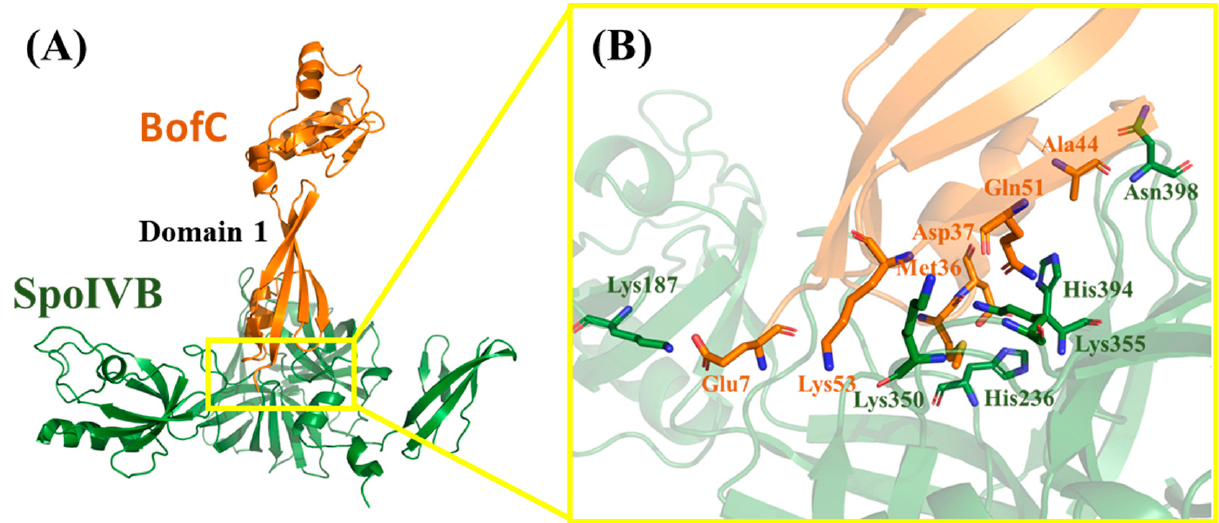
Figure 4. The docking result of BofC to SpoIVB. ( A ) Domain 1 of BofC participates in binding to the serine protease domain of SpoIVB, leading to BofC occupying the active site of SpoIVB that is normally occupied by its substrate or inhibitor. The structure of BofC is shown as orange and SpoIVB is shown in dark green. ( B ) The detailed interface between BofC and SpoIVB, and key residues involved in hydrogen bonds and salt bridges are shown in the stick model.